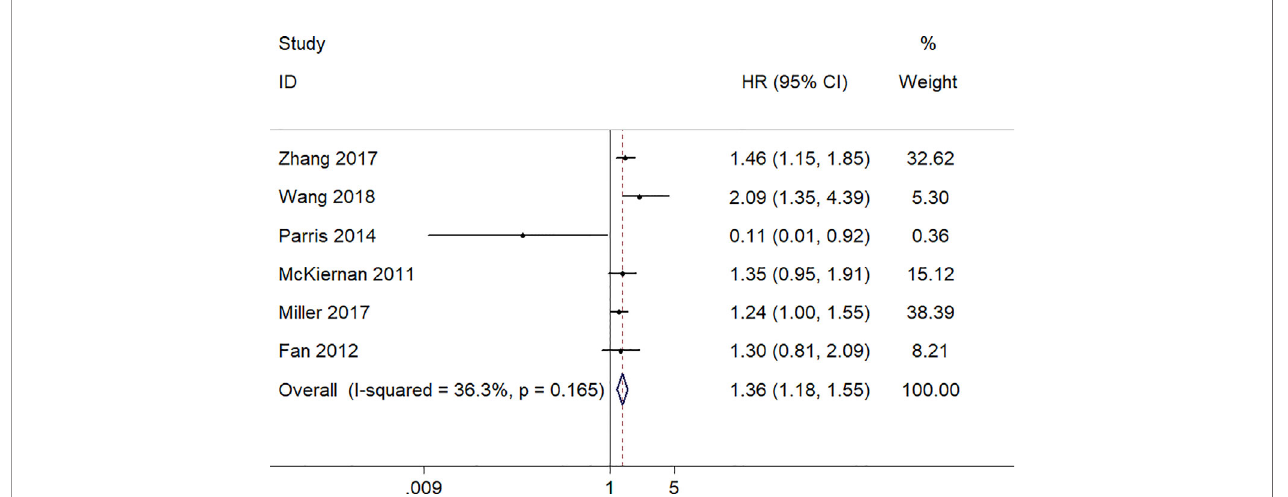
FIGURE 2 | Forest plot of studies evaluating hazard ratios of S100A8 overexpression and the overall survival of cancer